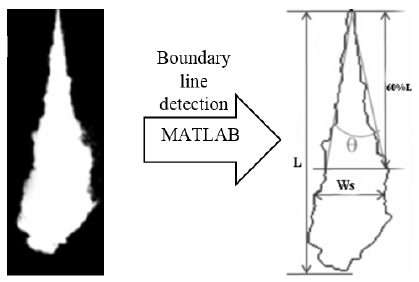
Figure 8. Spray boundary detection using MATLAB software.